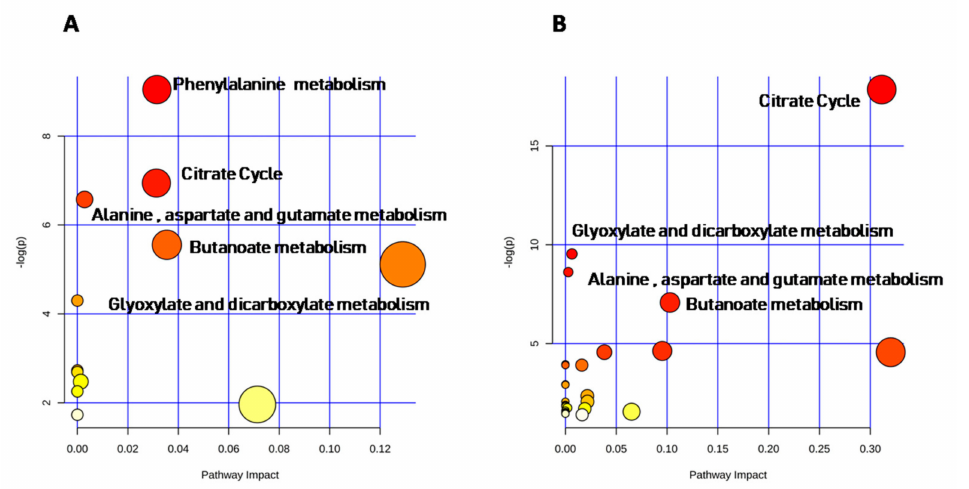
Figure 6. Metabolic pathway analysis for males ( A ) and females ( B ). Pathways analysis nodes were represented as a function of − log ( p ). Nodes color and size were based on p -values and the statistical significance (impact value),